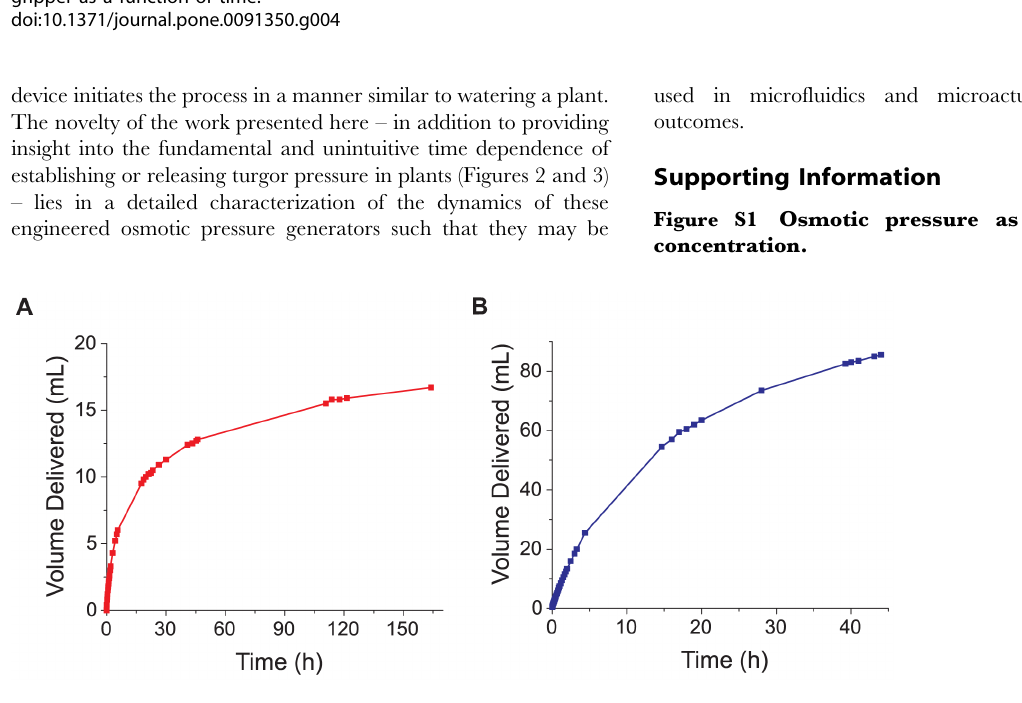
Figure 5. Time-dependent volume delivery using an osmotically-driven pressure generator as a pump. A . Cumulative volume delivered by a 3 mL dialysis cassette. B . Cumulative volume delivered by a 30 mL cassette. Both cassettes were restrained and filled with a 125 mM PEG-4000 solution and had a MWCO of 3.5 kDa.